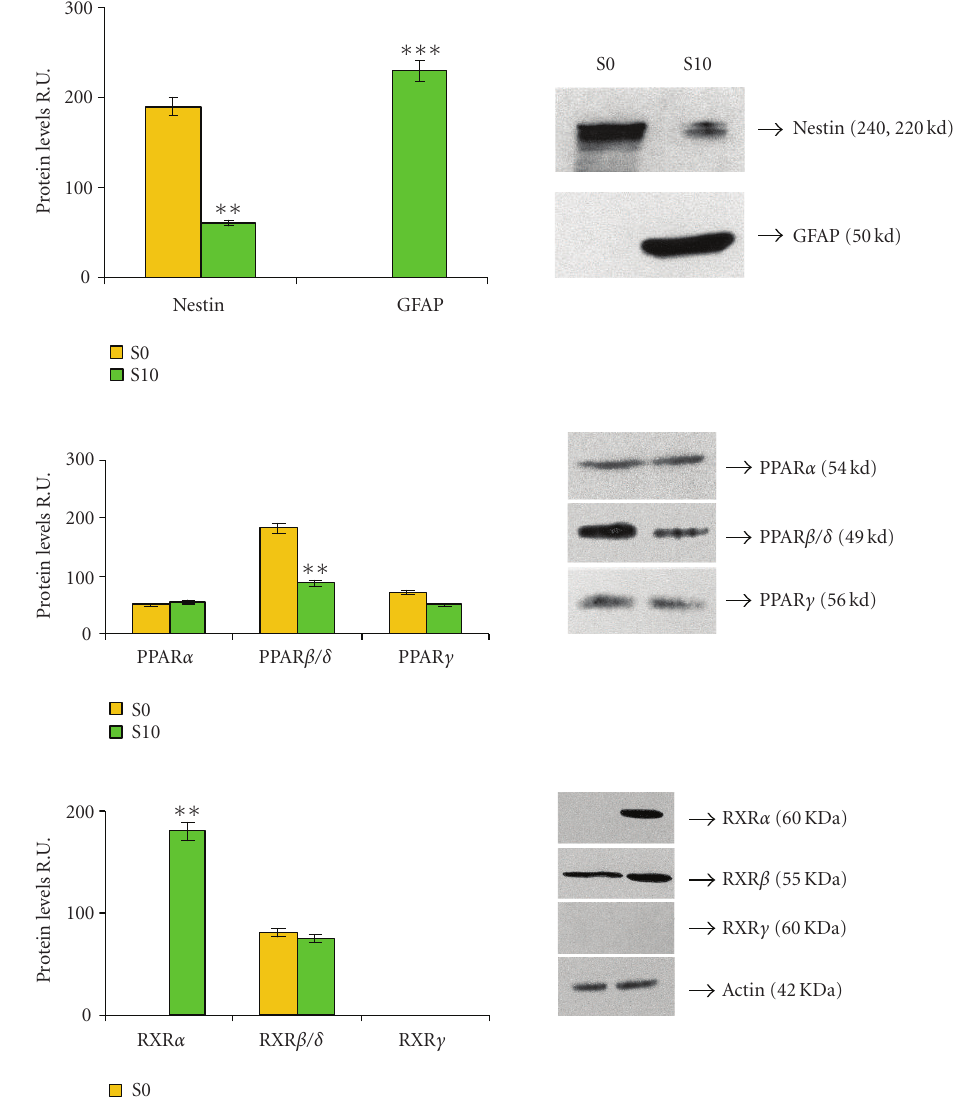
Figure 7: Western blotting and relative densitometric analysis in S10 neurosphere cell lysates. An example of western blotting is shown. Densitometric data are means ± SD of 5 di ff erent experiments. ∗ , P < . 05; ∗∗ , P < .